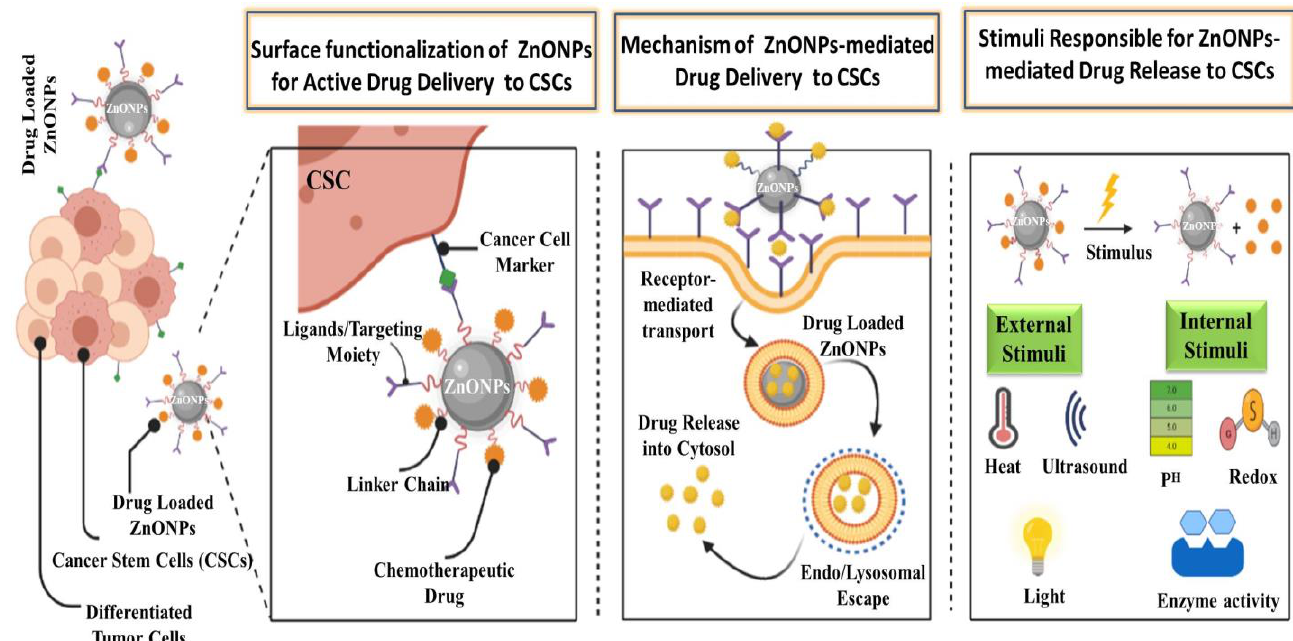
Figure 4. Graphical representation of the surface functionalization, mode of action, and various stimuli involved in targeted delivery of anticancerous drugs to cancer stem cells (CSCs) via ZnO NPs .